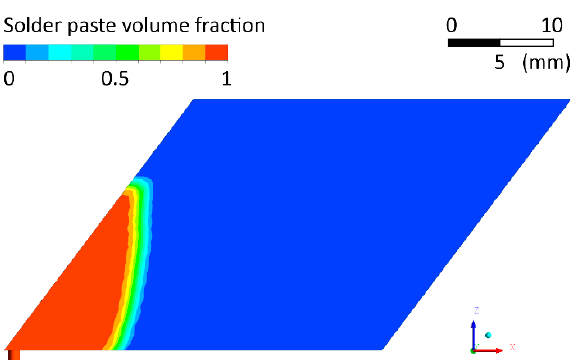
Figure 5. Calculating the hole-filling by the numerical model.